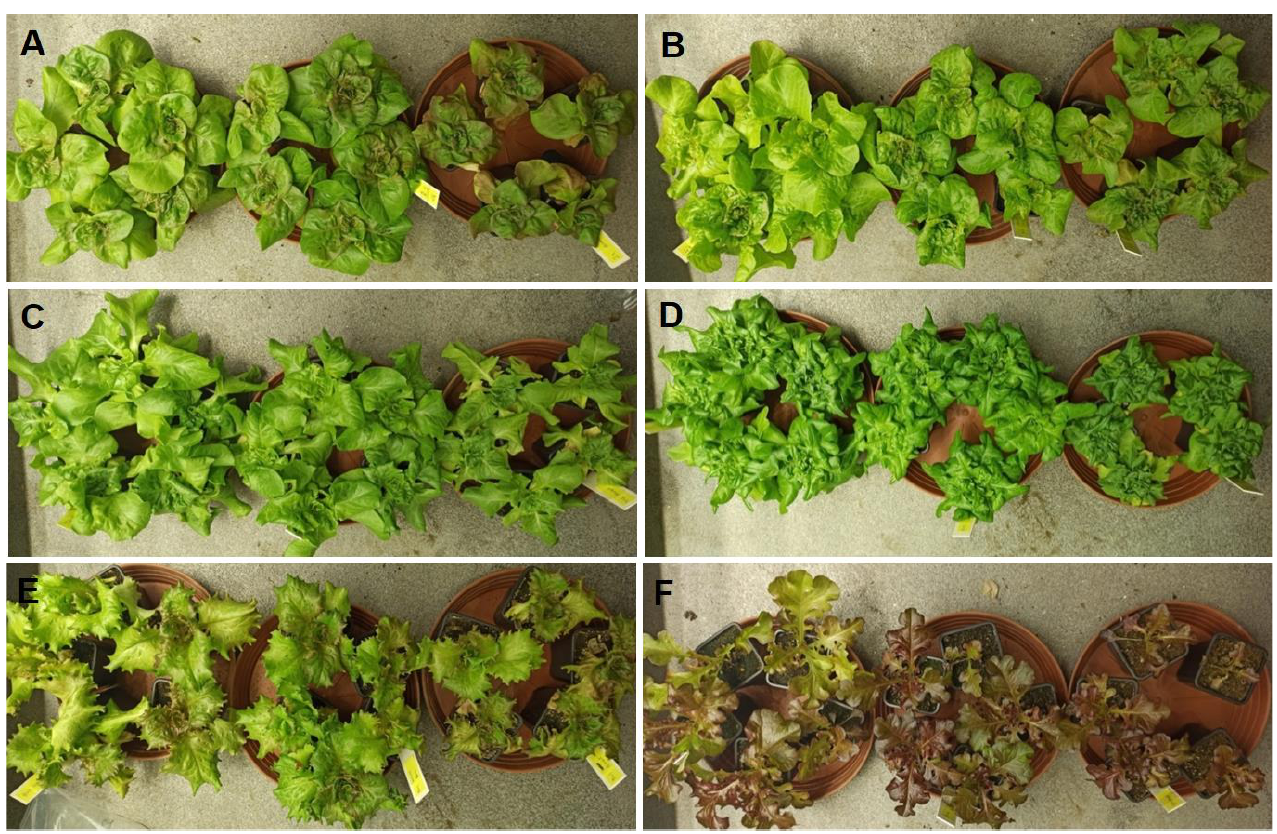
Figure 3. Lettuce varieties immediately before harvest. From left to right: control, salt stress, drought stress. ( A ) Altenbursky, ( B ) Kamenac, ( C ) Jupiter, ( D ) Dubacek, ( E ) Prazan, ( E ) Robin.